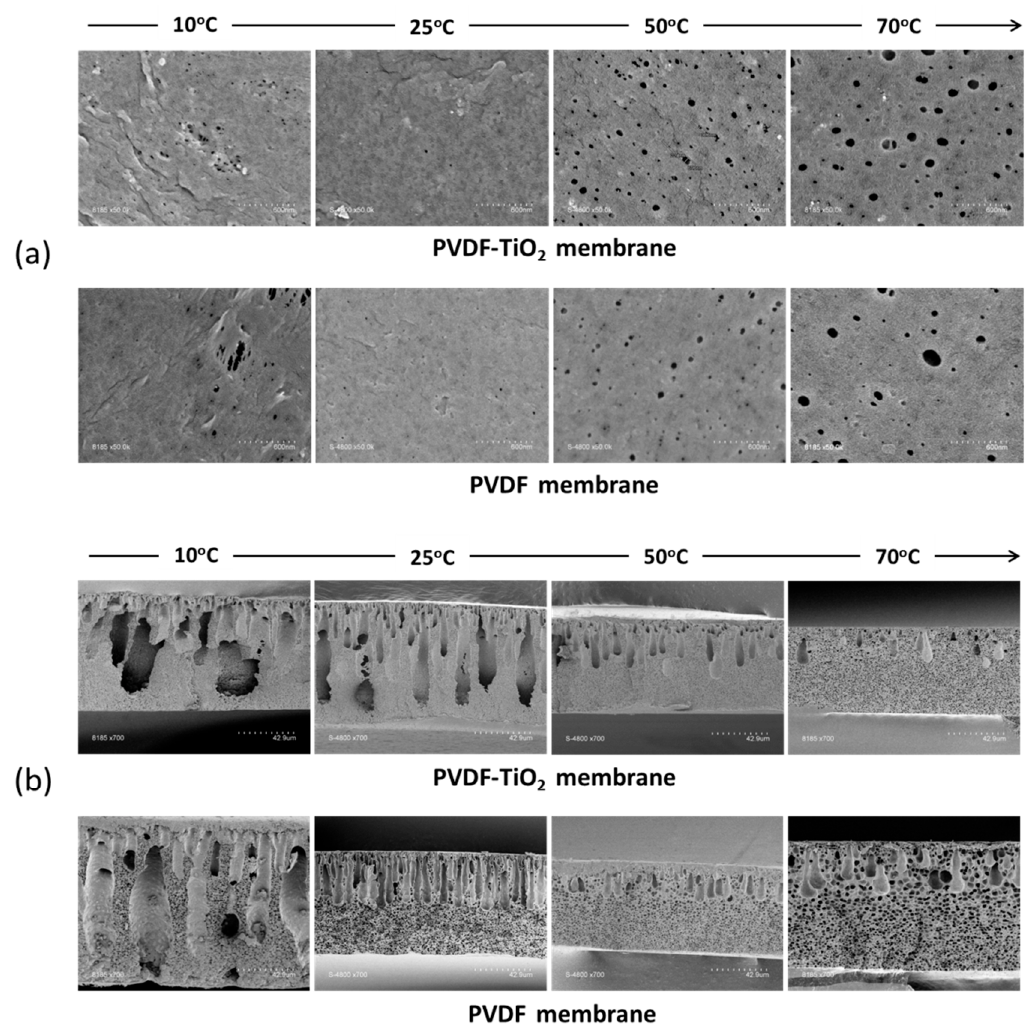
Figure 6. SEM images of PVDF-TiO 2 and PVDF membranes, ( a ) top surface and ( b ) cross section. The membrane active surfaces made at various temperatures can be seen in Figure